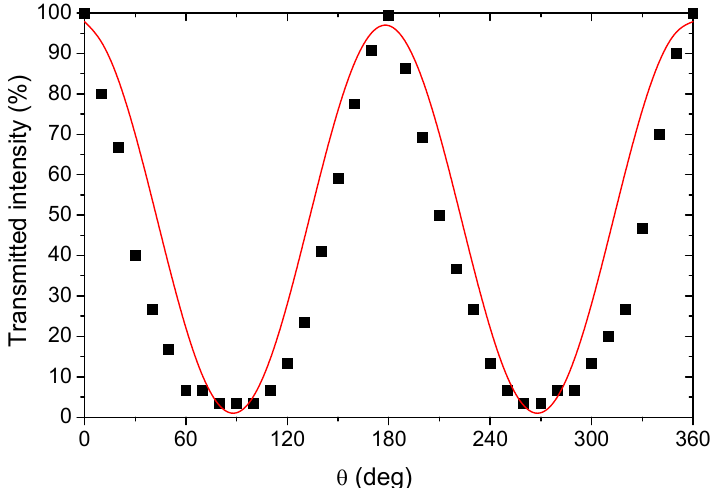
Figure 3. Transmitted intensity (black squares) in linearly polarized light for DR100 nanocomposite as a function of the angle θ between the polarization direction of the light and the drawing direction of the film. The red curve is a fit of experimental points according to Malus’ law.